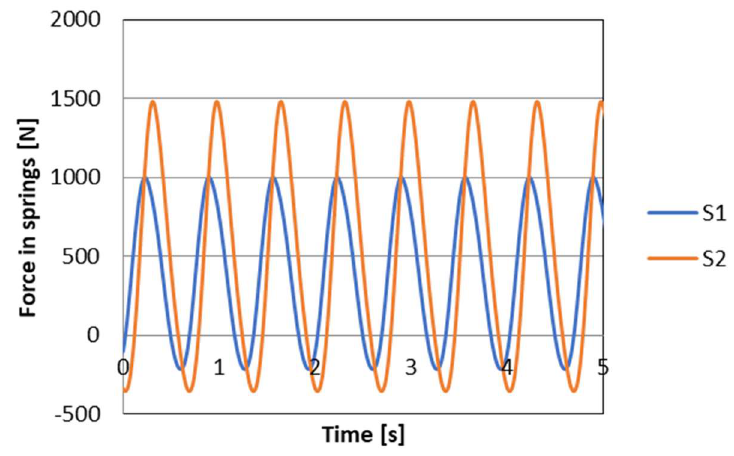
Figure 15. The course of the limit values of forces in the elastic elements of the suspension, respectively S1 front wheel, S2 rear wheel.